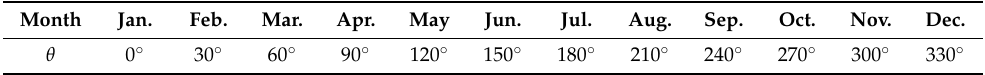
Table 1. Corresponding relation between month and